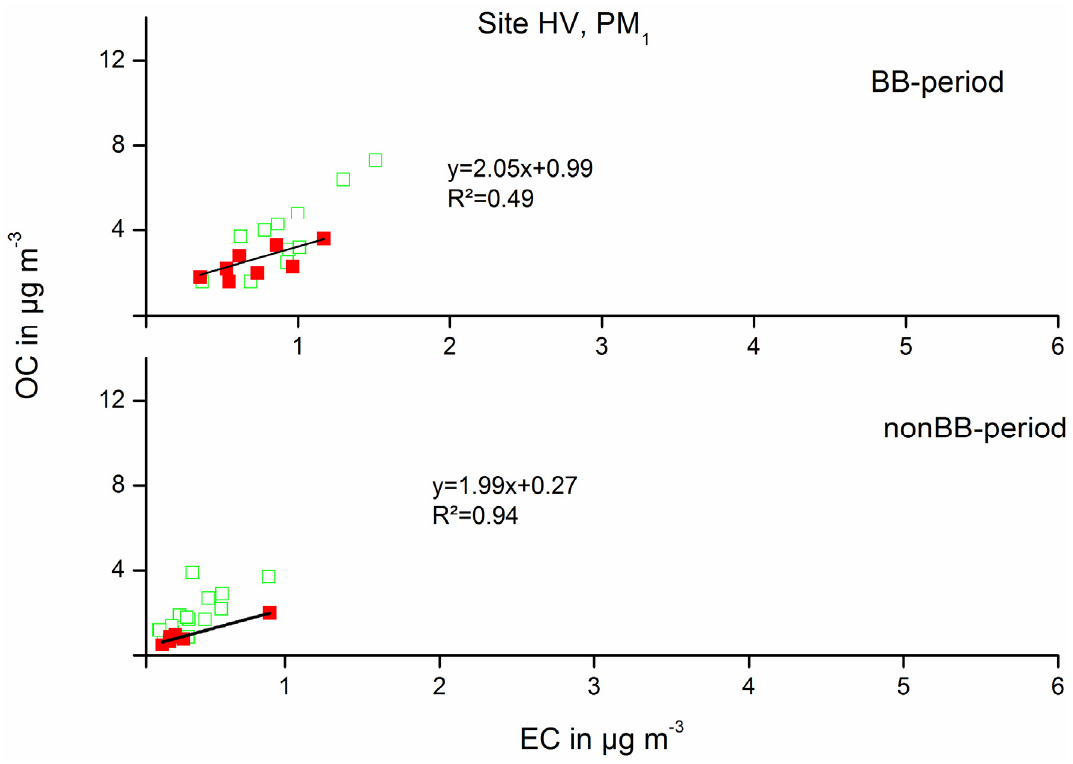
at site HV, PM p